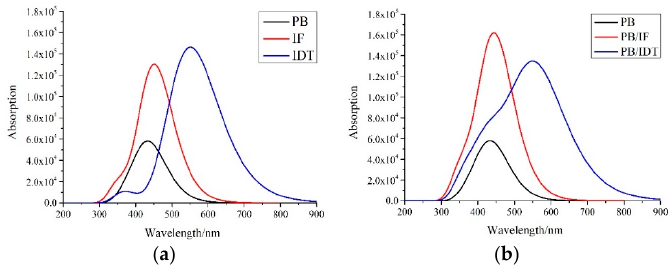
Figure 3. ( a ) The simulated absorption spectra of the NFAs IF-TN and IDT-TN, and donor PBDB-T. ( b ) The simulated absorption spectra of two interfaces (PB/IF and PB/IDT). Table 3. Values for transition energy E (eV), absorption peak λ (nm), oscillator strength, configuration interaction (CI) coefficient and excited-state lifetime τ (ns) of the NFAs IF-TN, IDT-TN and donor PBDB-T.